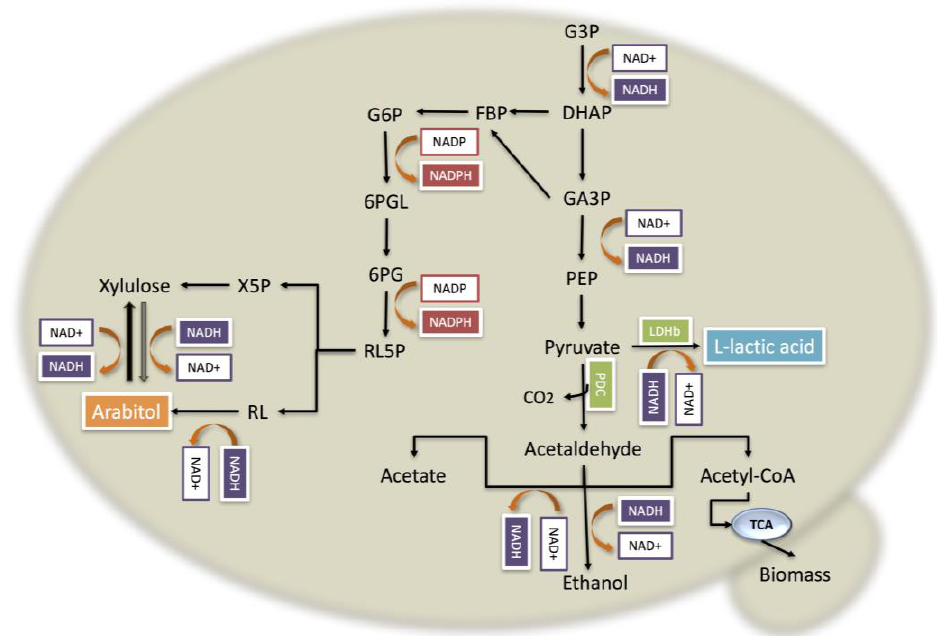
Figure 4. Glycerol metabolism of P. pastoris GLp strain showing the main pathways involved in